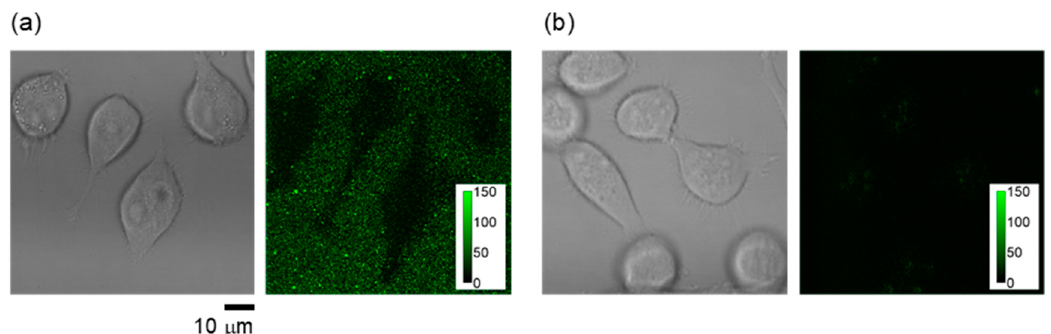
Figure 6. Reduction of background noise in the fluorescence image of HeLa cells with NANOGEL- 6 by the modified incorporation method using suspended cells. ( a ) Transmitted light image (left) and confocal fluorescence image (right, excitation: 458 nm; emission: 500–600 nm) at 37 °C when NANOGEL- 6 was introduced into adherent HeLa cells attached on a dish.; ( b ) Transmitted light image (left) and confocal fluorescence image (right, excitation: 458 nm; emission: 500–600 nm) at 37 °C when NANOGEL- 6 was introduced into suspended HeLa cells before scattering on the dish. The confocal fluorescence images were focused on the glass surface of the dish. Color bars in the fluorescence images indicate the fluorescence intensity (arbitrary unit).